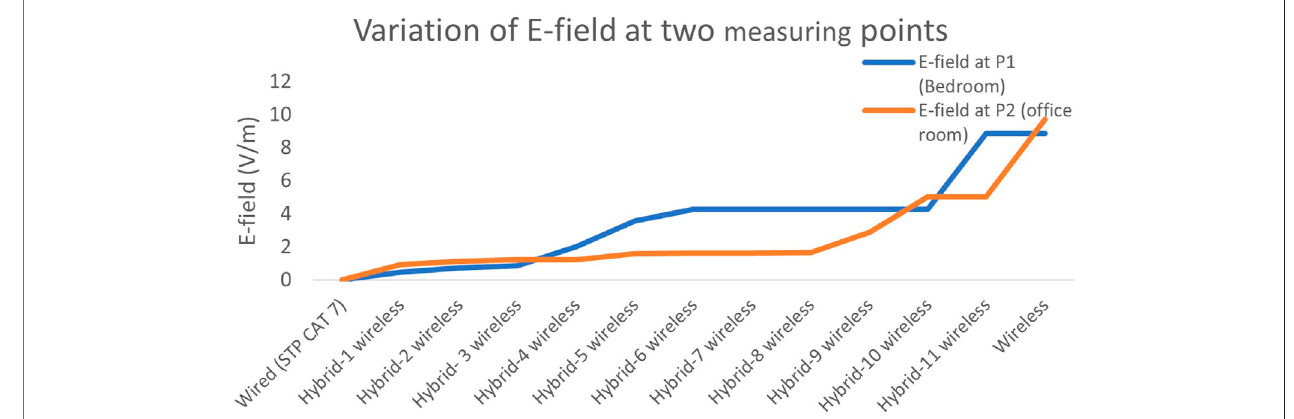
FIGURE 10 | Graph showing the E- fi eld variation at two measuring points.